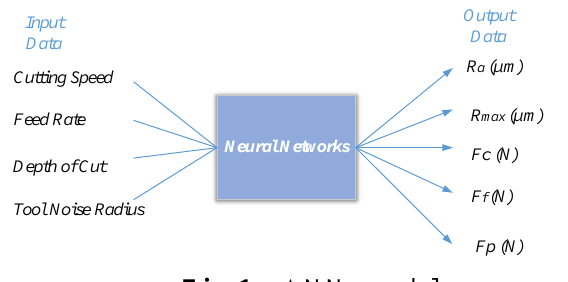
Fig. 1. ANN model Fig. 2. Schematic diagram of